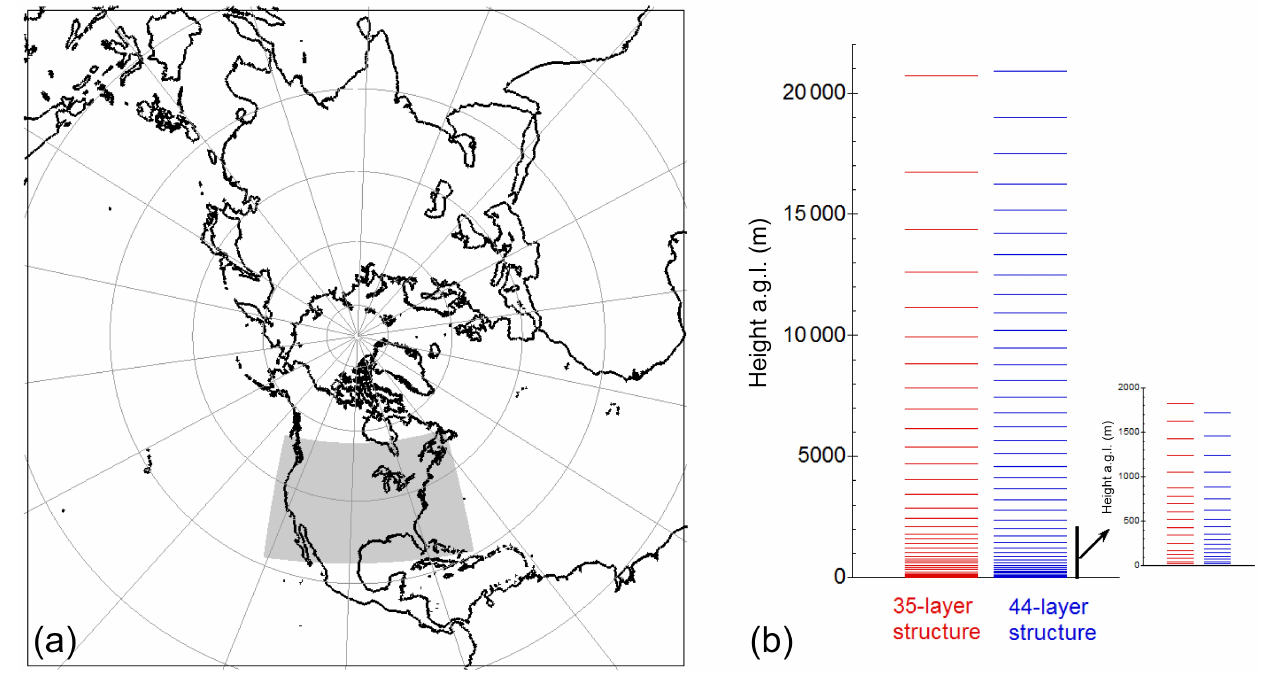
Figure 2. (a) The Northern Hemisphere modeling domain discretized using a 108km resolution grid. The shaded region shows the extent of the typical continental US nested domain discretized using a 12km resolution horizontal grid. (b) Comparison of two layer configurations used to discretize the vertical extent ranging from the surface to 50hPa.